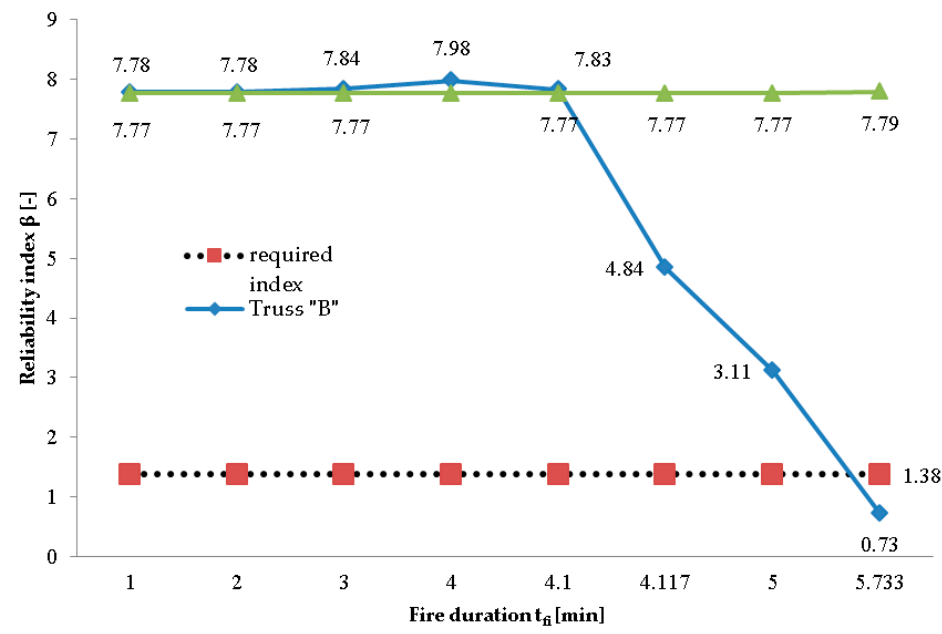
Figure 12. Change in the reliability index of truss “B”.